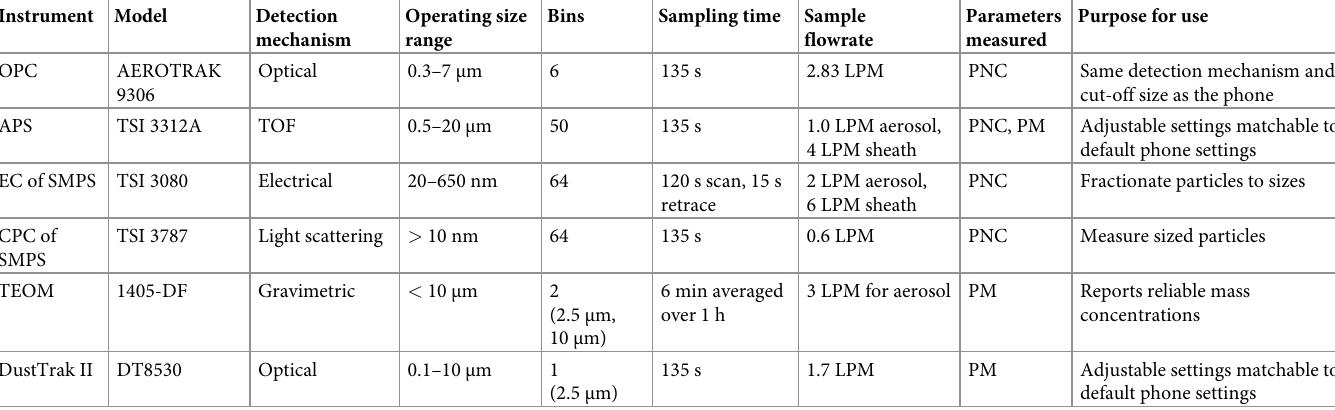
Table 1. Summary of the operating parameters and settings of all the instruments used for particle matter characterisation. Instrument